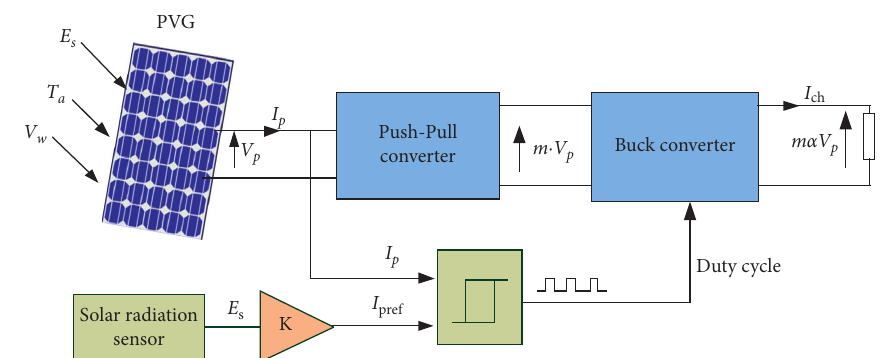
Figure 6: Structure of the hysteresis current controller